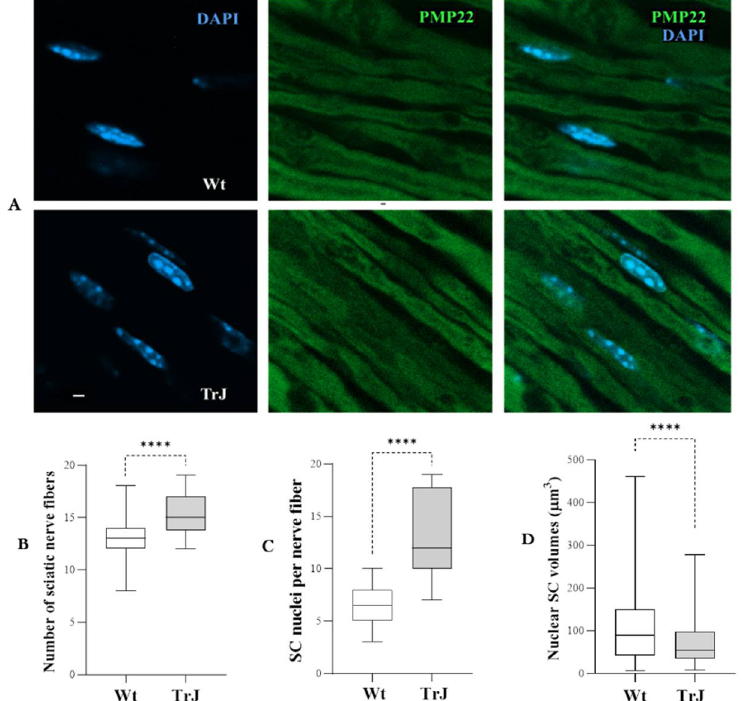
Figure 1. Fibers and Schwann cell nuclei in Wt and TrJ sciatic nerves. ( A ): Confocal images of Wt and TrJ sciatic nerve fibers. ( B – D ): Box plots illustrating the distribution of number of fibers, and SC nuclei through the whole thickness of sections and SC nuclear volumes ( µ m 3 ) of Wt and TrJ, respectively. The fibers were immunostained using anti-PMP22 (green), after epitope retrieval (70% formic acid), and counterstained with DAPI (blue). Both areas and volumes were measured on DAPI channel. Boxes enclose the data comprising between the 25th and 75th percentiles (50% of the data). The median (50th percentile) is denoted by the transversal line within each box. Differences between Wt and TrJ were examined by means of Mann–Whitney tests (**** p -values < 0.0001). Number of panoramic images analyzed = 20 per genotype. Volumes were calculated in 150 SC nuclei per genotype. Scale bar = 2 µ m. Both the fiber and SC nucleus numbers were significantly larger in TrJ than in Wt sciatic nerves, whereas SC nuclear volume was significantly smaller in TrJ than Wt